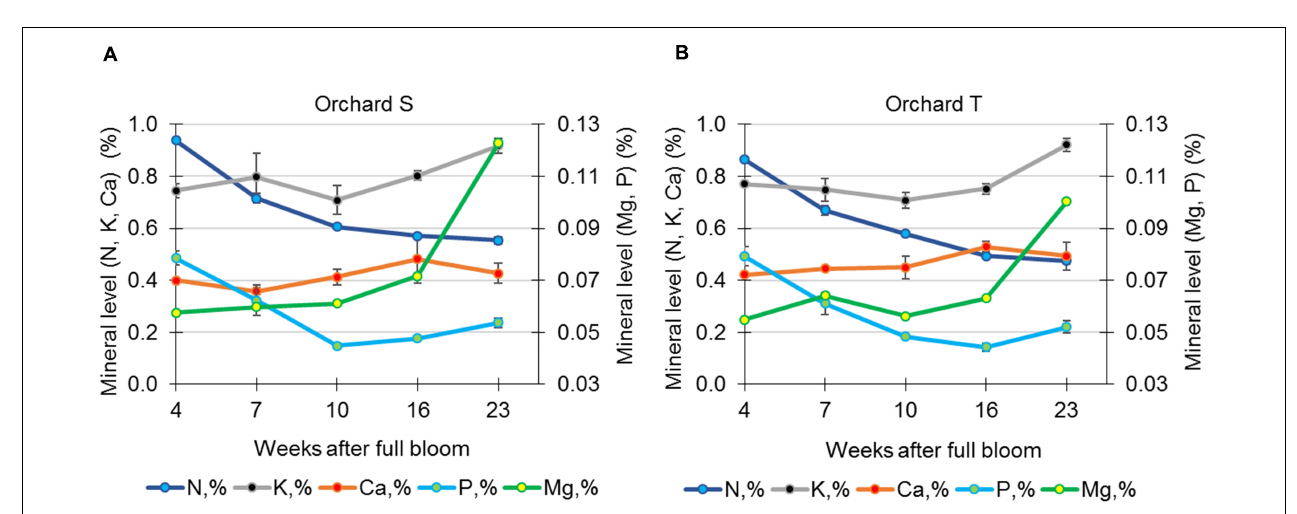
FIGURE 5 | Epidermal cell density in pomegranate skin during the growing season of 2017. Data represent fruit from orchards S (A) and T (B) . The number of epidermal cells in histological sections was counted along a 1-mm line. Values are averages of three replicate fruit ± SE. Data were analyzed for statistical significance by Student’s t -test. Mean values with different letters differ significantly at P < 0.05.